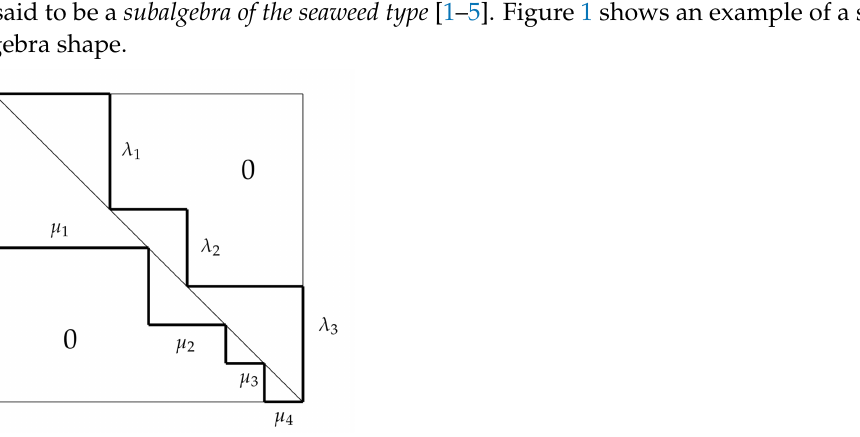
Figure 1. Seaweed algebras are subalgebras of the full-matrix